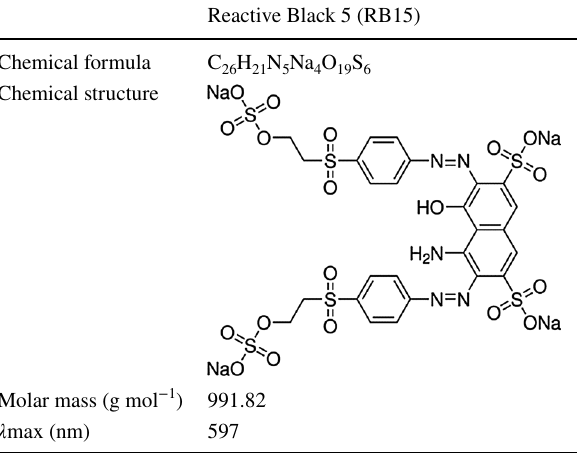
Table 1 General characteristics of Reactive Black 5 dye Reactive Black 5